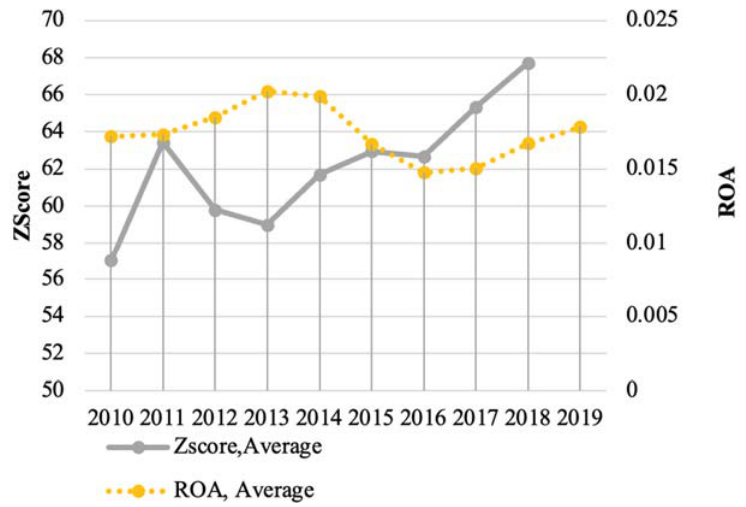
Figure 1. Z ‐ score and ROA for ASEAN countries. Figure 1. Z-score and ROA for ASEAN